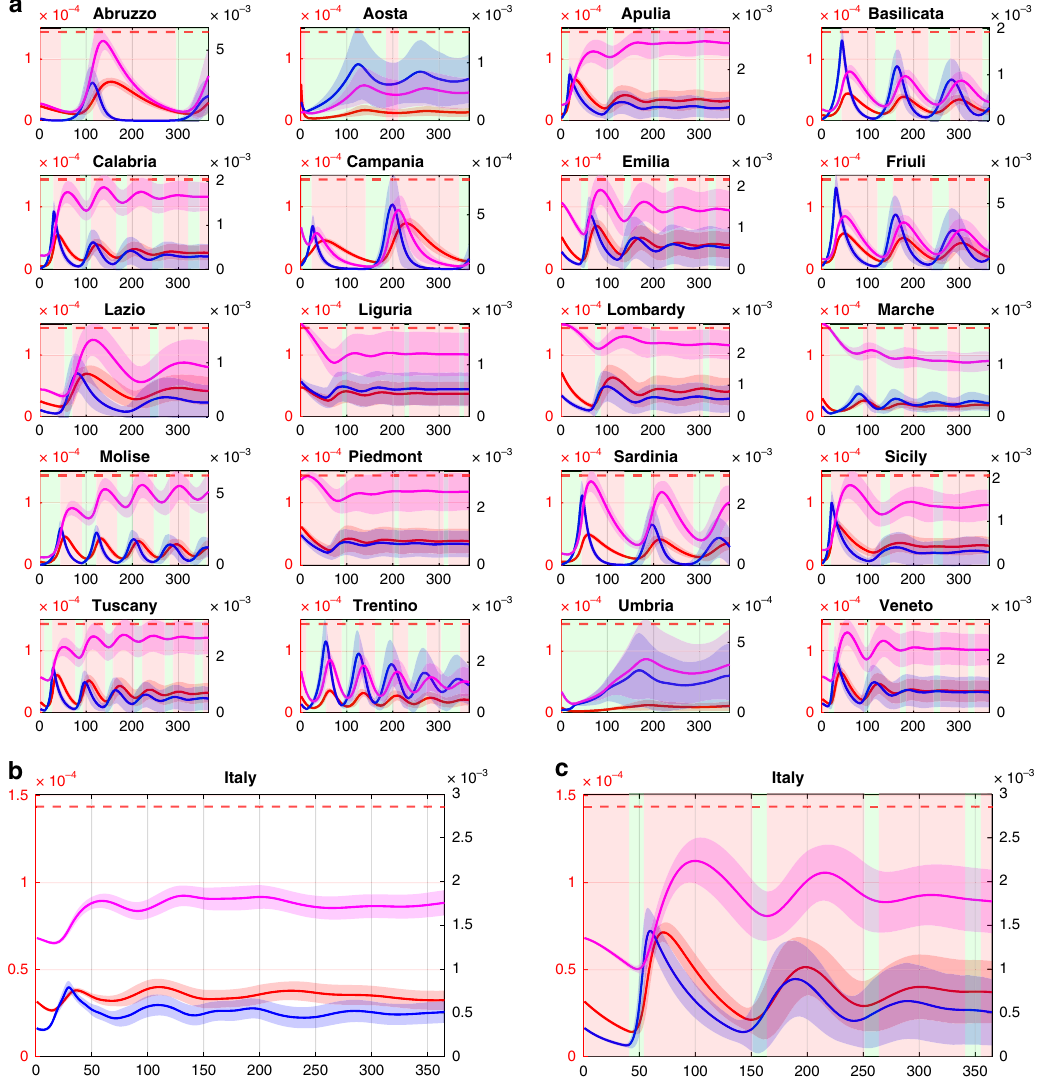
35000.511.5 00.511.522.53 Fig. 3 Intermittent regional measures. a Each of the 20 panels shows the evolution in a different region of the fraction in the population of infected (blue), quarantined (magenta) and hospitalized requiring ICUs (red) averaged over 10,000 simulations with parameters sampled using a Latin Hypercube technique (see Methods) around their nominal values set as those estimated in the last time window for each region as reported in Supplementary Table 4. Shaded bands correspond to twice the standard deviation. Dashed red lines represent the fraction of the population that can be treated in ICU ( T H i = N i ). Regions adopt lockdown measures in the time windows shaded in red while relax them in those shaded in green. During a regional lockdown, fl uxes in/out of the region are set to their minimum level. b National evolution of the fraction in the population of infected (blue), quarantined (magenta) and hospitalized requiring ICUs (red) obtained by summing those in each of the 20 regions adopting intermittent regional measures. c National evolution of the fraction in the population of infected (blue), quarantined (magenta) and hospitalized requiring ICUs (red) when an intermittent national lockdown is enforced with all regions shutting down when the total number of occupied ICU beds at the national level exceed 20%, reopening when it goes back below 10%. Regional dynamics corresponding to this scenario are shown in Supplementary Fig. 4. All plots are shown with a double scale. The scale on the left vertical axis (in red) applies to the hospitalized requiring ICU and the ICU beds capacity threshold, while the right vertical axis (in black) applies to the infected and quarantined. The time scale, on the horizontal axis, is given in ferent con fi gurations of the links among its compartments affected the model ability to capture the available data.